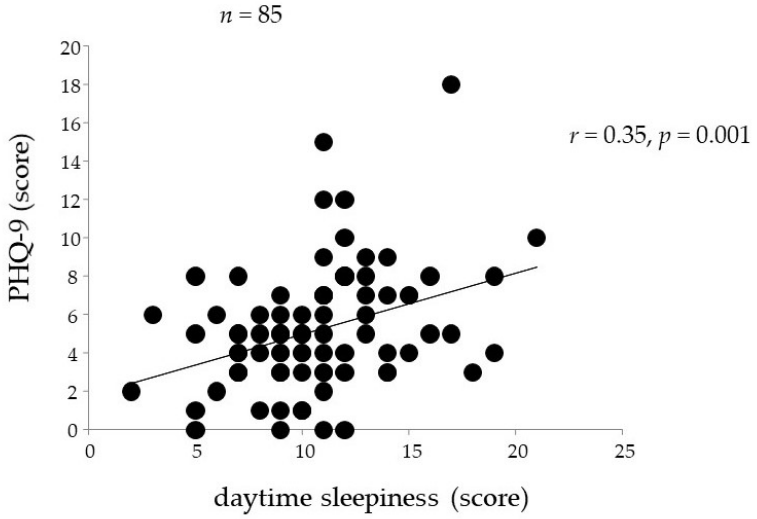
Figure 1. Relationship between PHQ-9 score and daytime sleepiness.